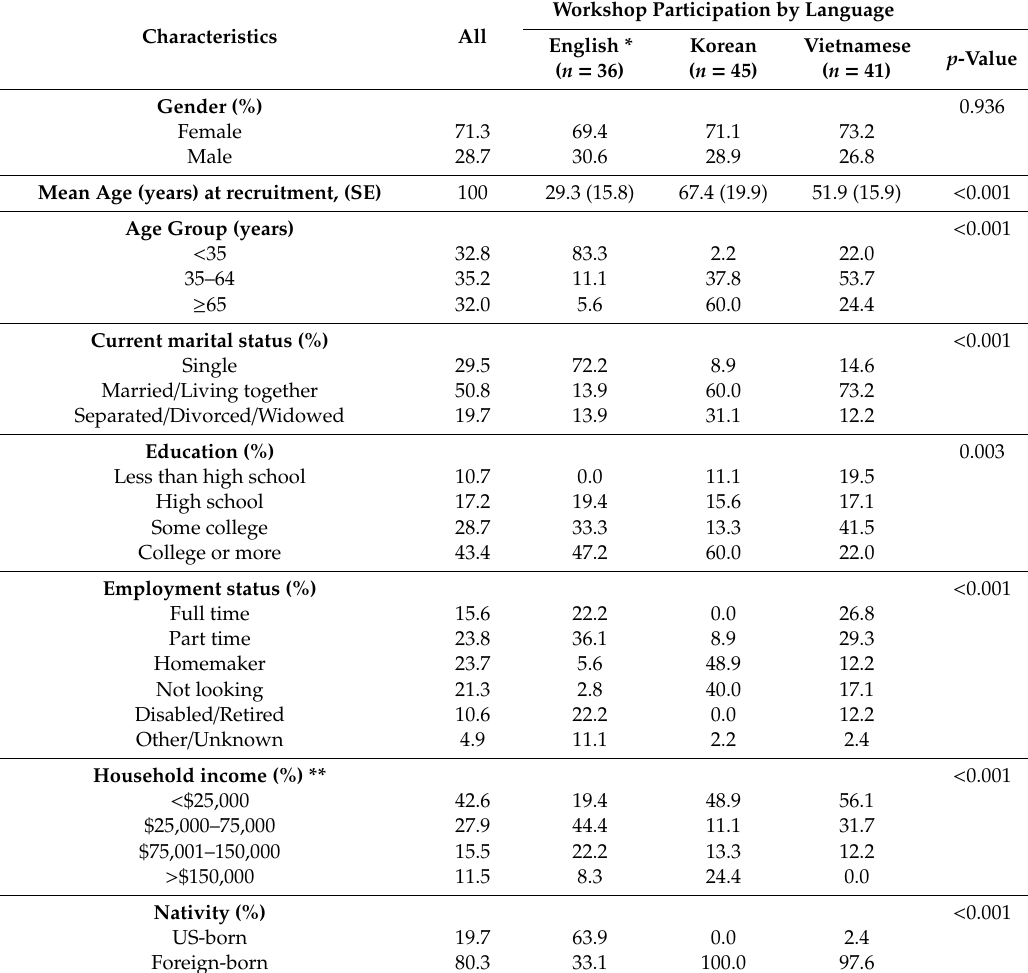
Table 1. Sample Characteristics, Overall and By Workshop Participation ( n =